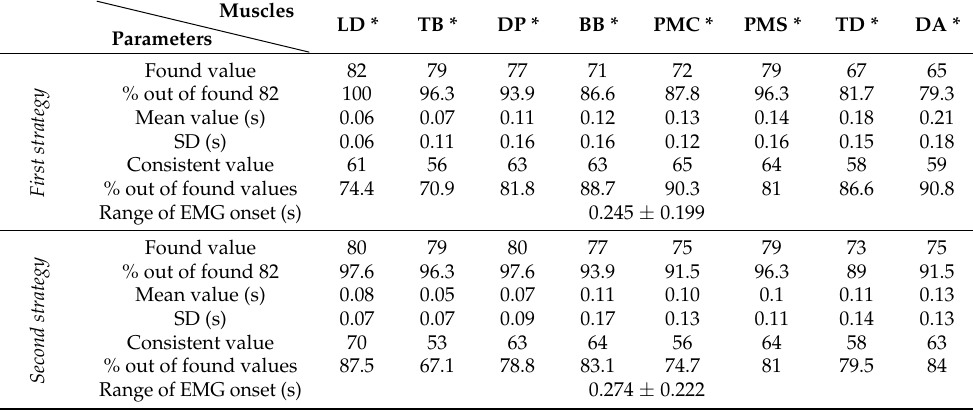
Figure 6. Kurtosis robustness values for both data smoothing techniques and raw data. Table 2. Descriptive results for all 4